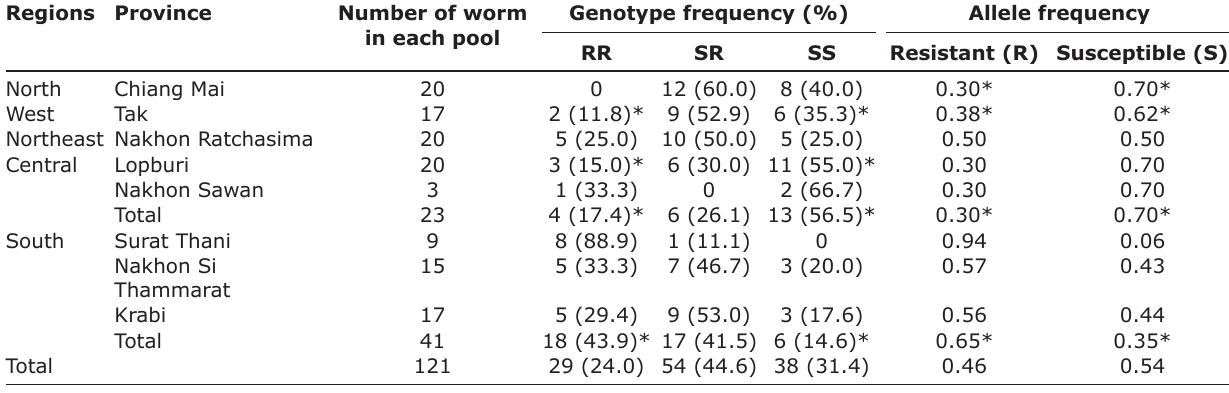
Table-2: Genotype and allele frequencies associated with BZ in Haemonchus contortus adult from goats in eight provinces of five regions, Thailand. Regions Province